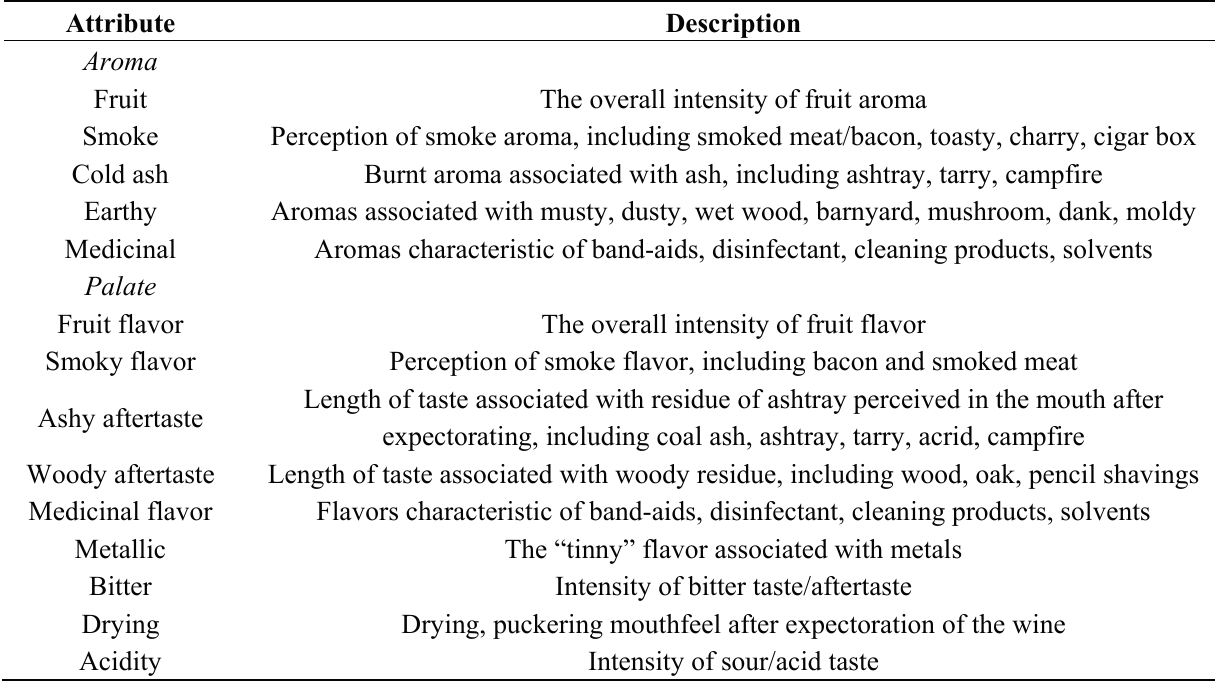
Table 3. Aroma and palate attributes used for sensory analysis of control and smoke-affected